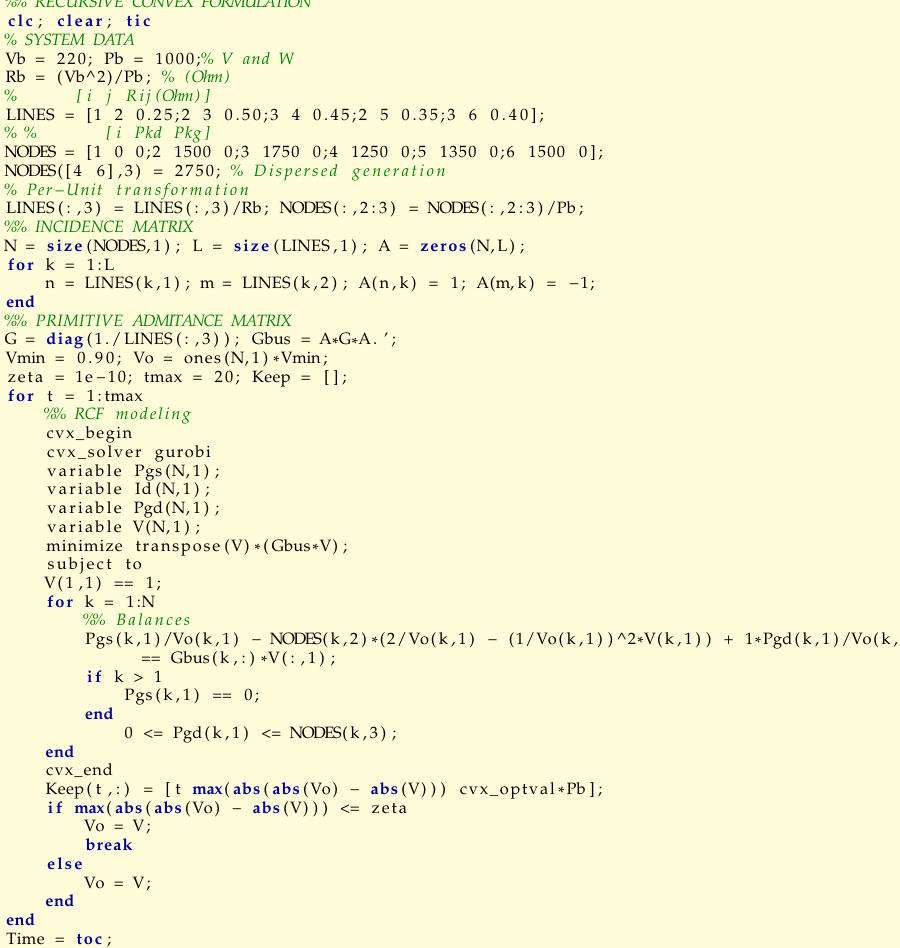
Figure 2. MATLAB implementation of the proposed RCF to the six-bus system. Table 5. Branch and load parameters for the fsix-bus grid in mopololar DC applications Node j Node k